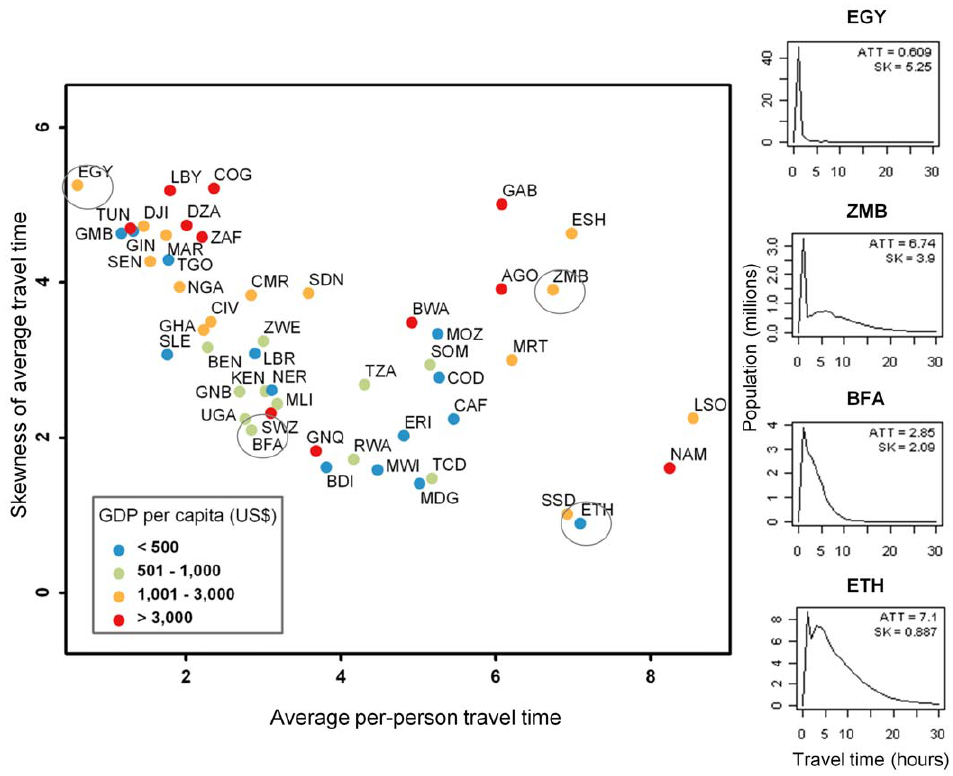
Figure 3. Scatterplot of the average per-person travel time versus the skewness of this average travel time. The X-axis represents the average per-person travel time to the nearest settlement with more than 50,000 people and the Y-axis is the skewness of the average travel time distribution. Examples of corresponding national travel time distribution plots are shown on the right. Colors represent the GDP per capita for the year 2010, or the year 2009 when 2010 data were not available (World Bank national accounts data, and OECD National Accounts data files: http:// data.worldbank.org/indicator/NY.GDP.PCAP.CD). North and South Sudan share the same GDP per capita value, as no separate statistic is available at the